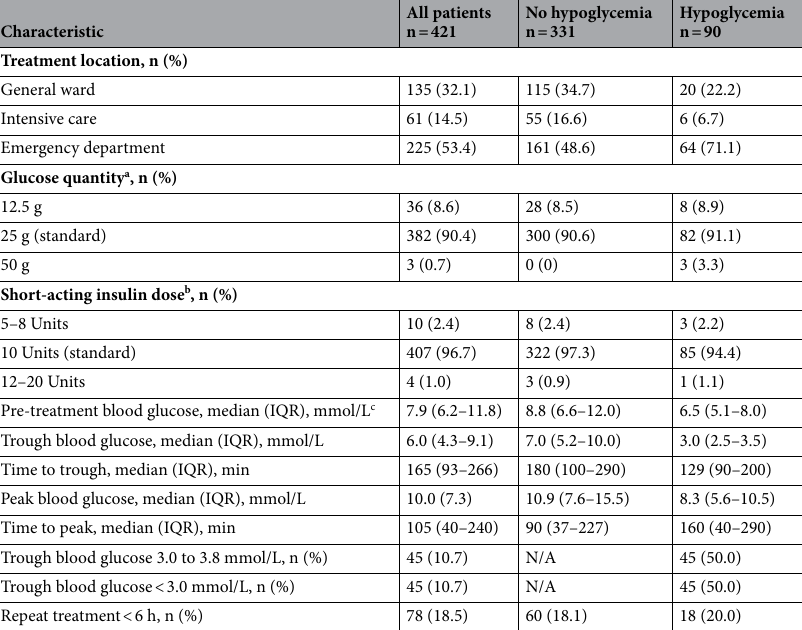
Table 2. Details of insulin-dextrose treatment and glucose levels. a Two patients received 10% dextrose rather than 50% dextrose. b Six patients received Novorapid 10 Units, rather than Actrapid 10 Units. c Missing observations in pre-treatment blood glucose (n =